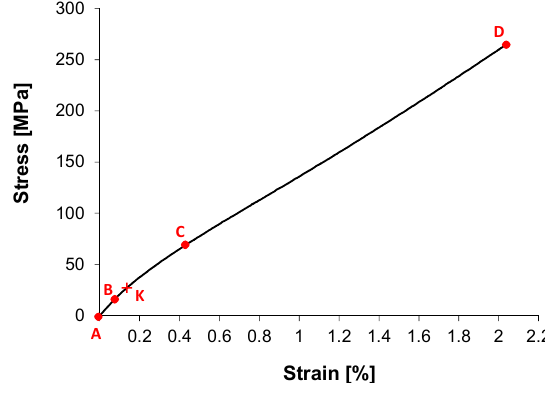
Figure 1. Typical tensile curve of a unidirectional (UD) Flax Fibre Reinforced Composite (FFRC) along the reinforcement orientation.